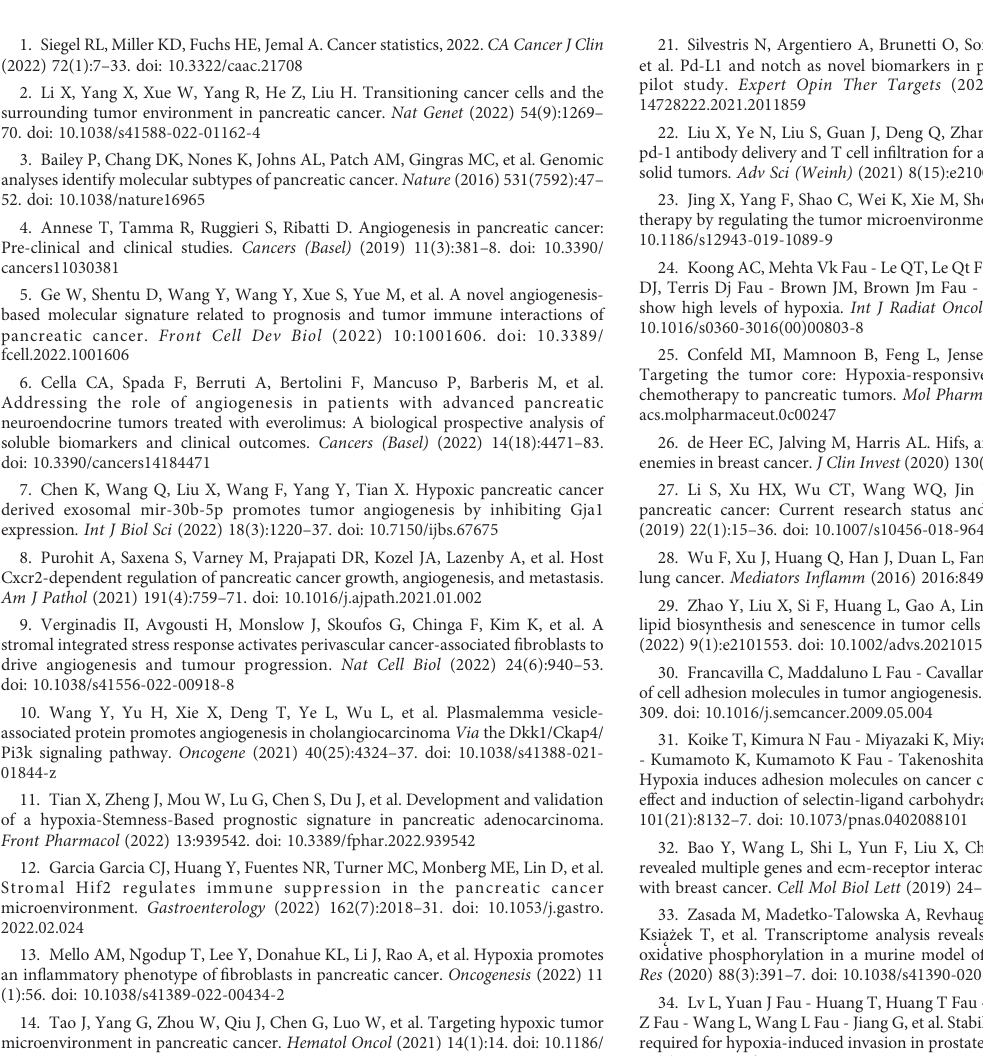
SUPPLEMENTARY TABLE 4 Construction of HAPM. SUPPLEMENTARY TABLE 5 Results of PPI network analysis.